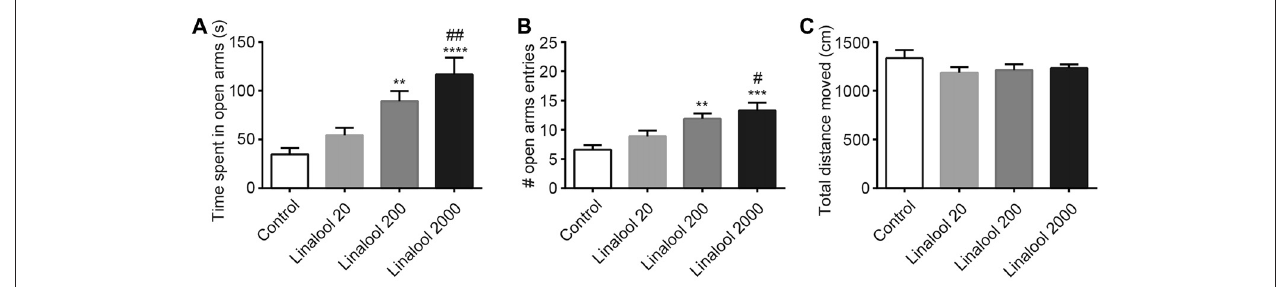
FIGURE 2 | Dose-dependency of anxiolytic effects of linalool odor exposure. Time spent in open arms (A) and number of entries to open arms (B) indicate that the anxiolytic effects were dependent on the linalool concentration. (C) Spontaneous locomotor activity was not impaired by linalool odor exposure. Total distances moved during 5 min in the EPM were not significantly varied. Control, mice exposed to odorless air-exposed mice; Linalool 20, mice exposed to 20 µ L of linalool; Linalool 200, mice exposed to 200 µ L of linalool; Linalool 2,000, mice exposed to 2,000 µ L of linalool; n = 10 for all groups. Results are expressed as mean ± SEM. ∗∗ P < 0.01, ∗∗∗ P < 0.001, ∗∗∗∗ P < 0.0001 compared to the Control group. # P < 0.05, ## P < 0.01 compared to the Lin 20 group ( post hoc Tukey’s multiple comparison